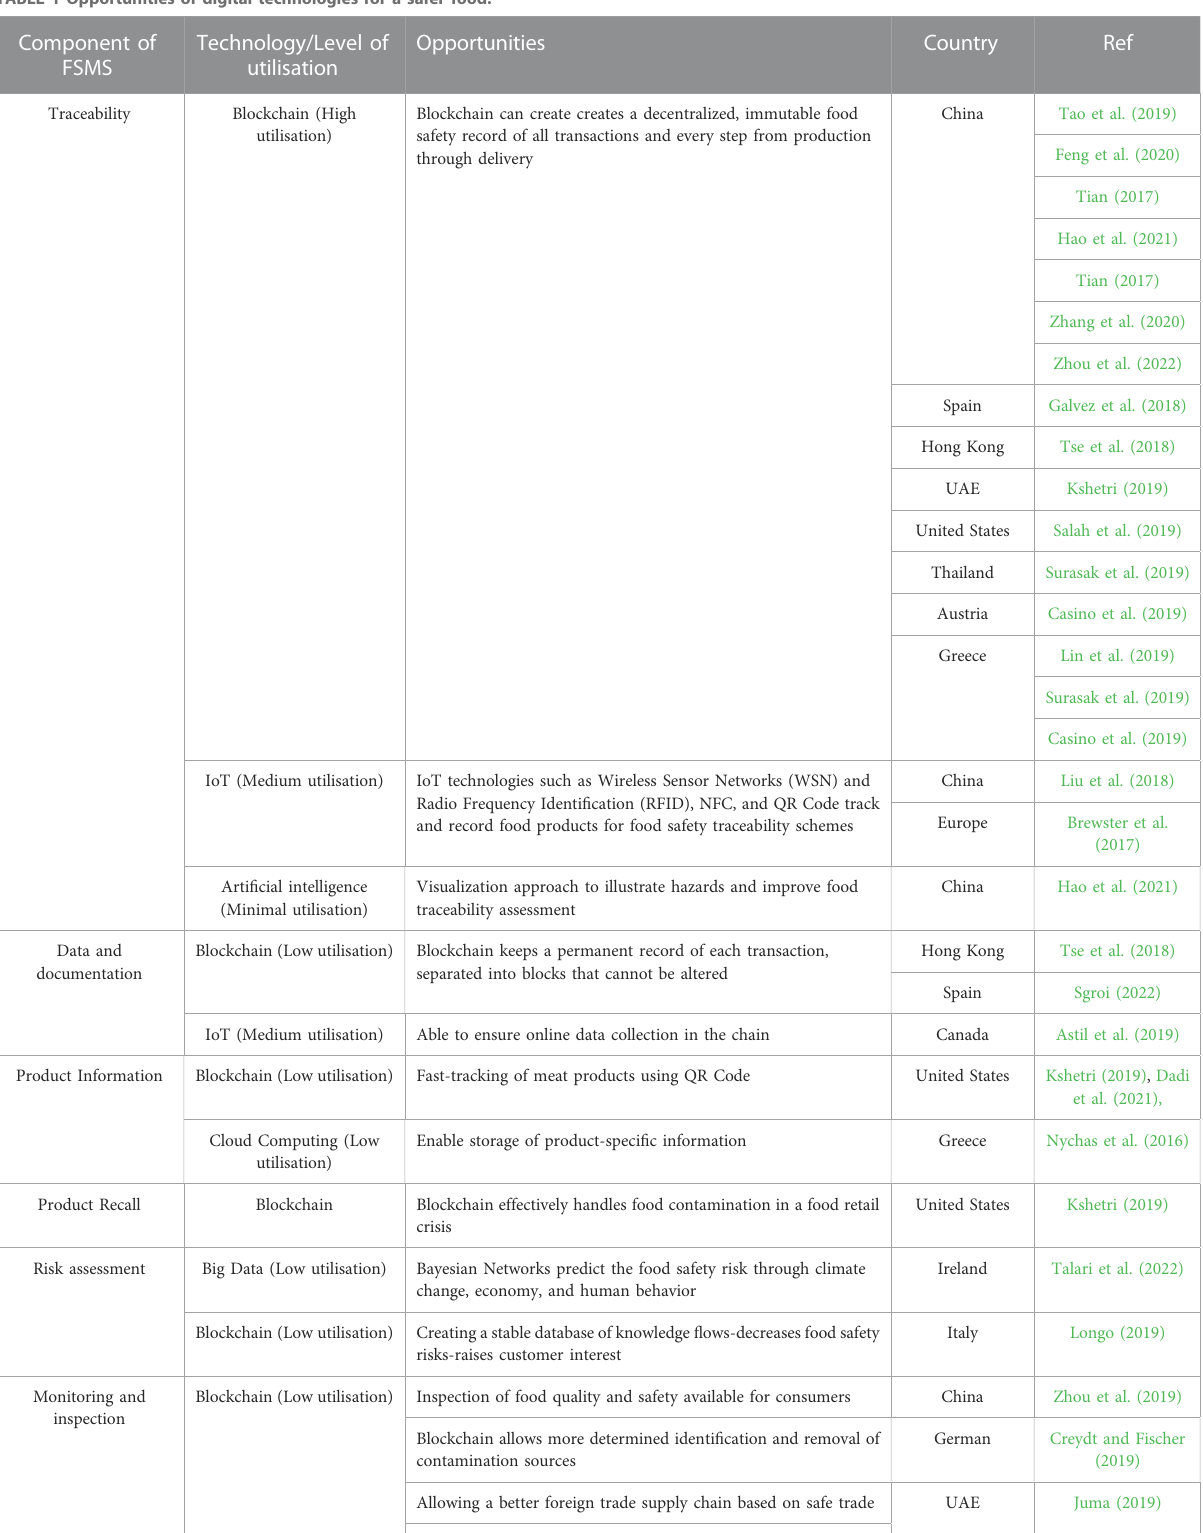
TABLE 1 Opportunities of digital technologies for a safer